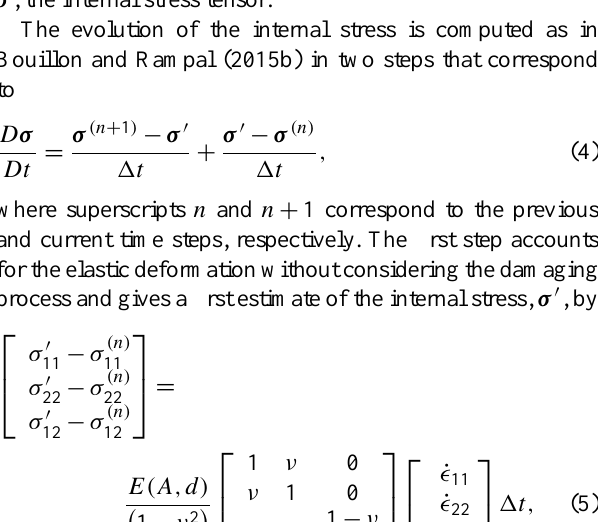
surface of ice per unit